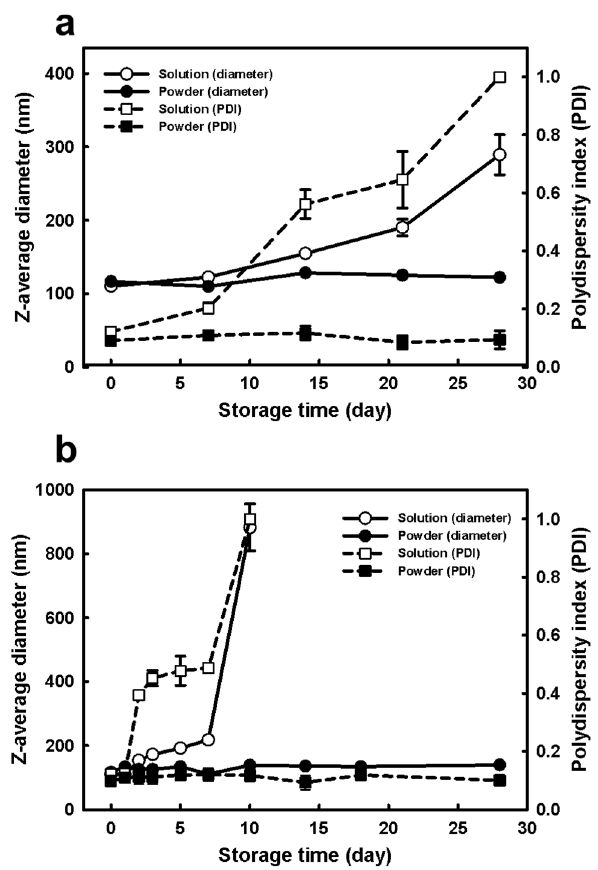
Figure 6. Storage stability of lipid nanovesicle solutions and lyophilized lipid nanovesicle powders incubated at ( a ) 4 °C and ( b ) 30 °C. The lyophilized sample was produced via lyophilization with lyoprotective agent (LPA) and controlled rate slow freezing (CSF) using isopropanol. Diameter, Z-average diameter; PDI, polydispersity